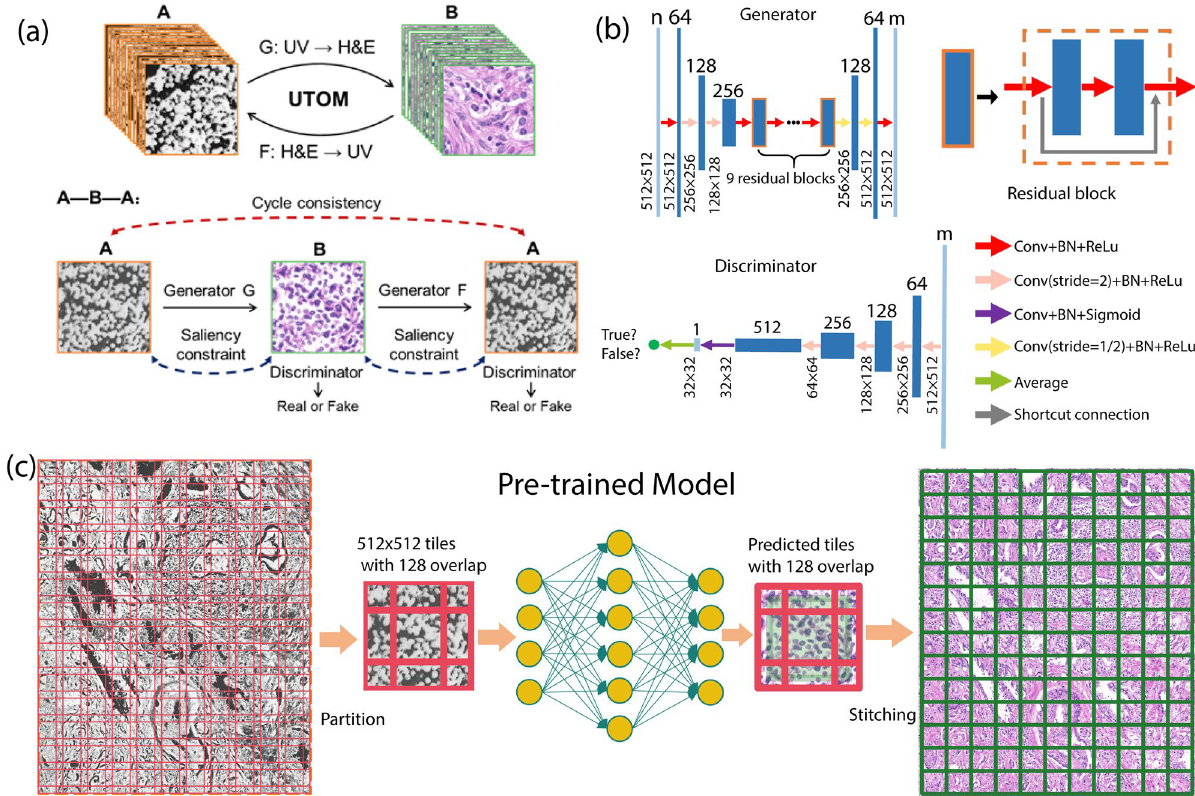
Figure 6. Schematic of colorization process and the UTOM method For the transformation from UV to HE, input channels N = 4, and output channels M = 3. Each coral rectangle represents a feature map extracted by corresponding convolutional kernels. The generator is a multi-layer residual network with downsampling input layers and upsampling output layers. The discriminator (PatchGAN classifier) uses multiple strided convolution for abstract representation. It generates a matrix, in which each element corresponds to a patch in the input image. The ultimate output is the average of the loss over all